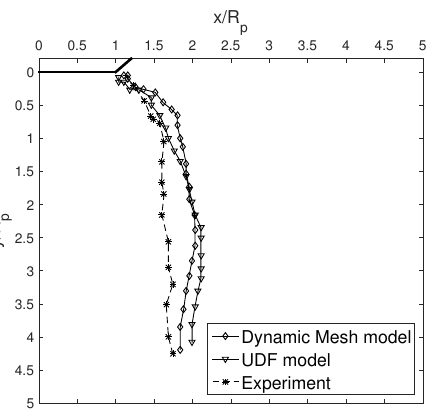
Figure 5. Vortex core trajectory of vortex rings produced by computational fluid dynamics (CFD) model and the